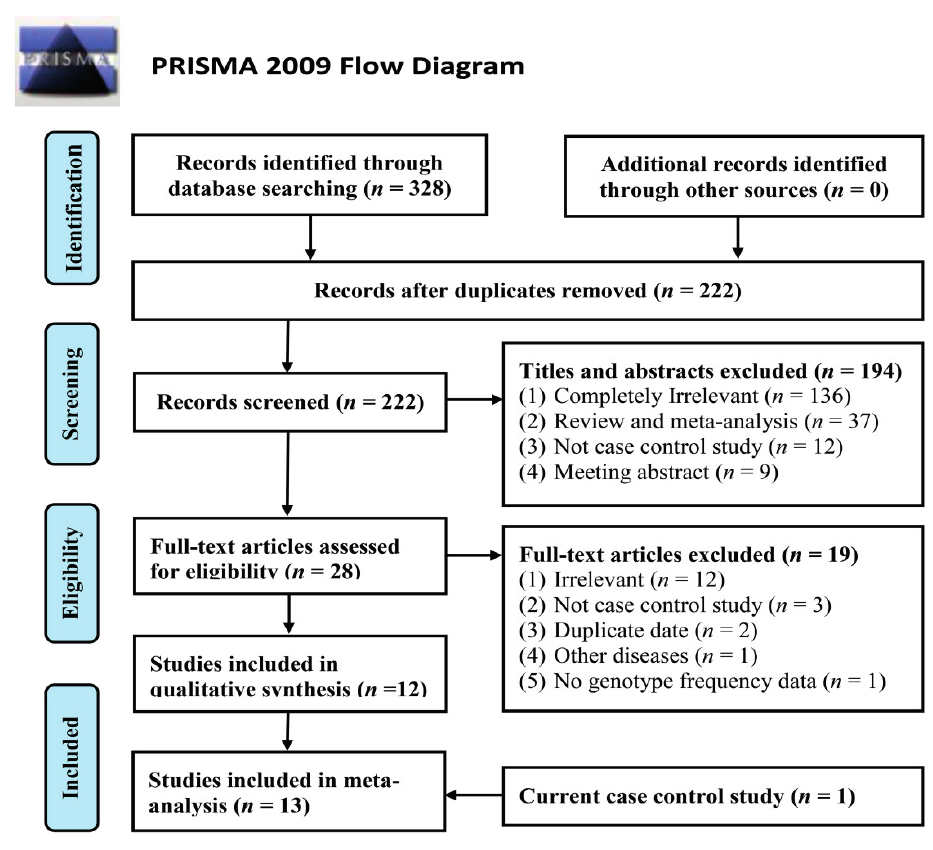
Figure 1. Flow diagram of the study selection process in this